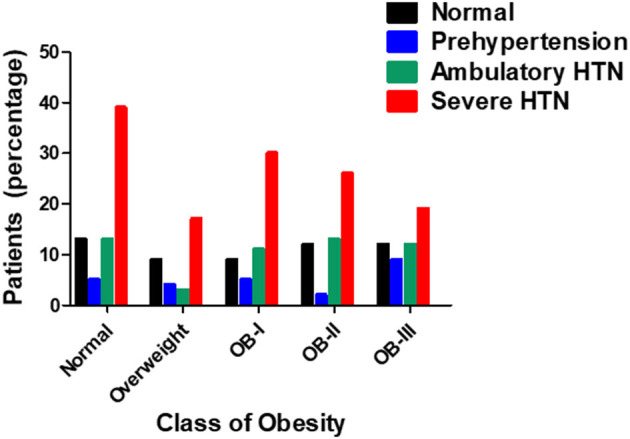
Prevalence of hypertension in relation to stage of obesity (n = 263) as tested by Pearson's chi square-test.